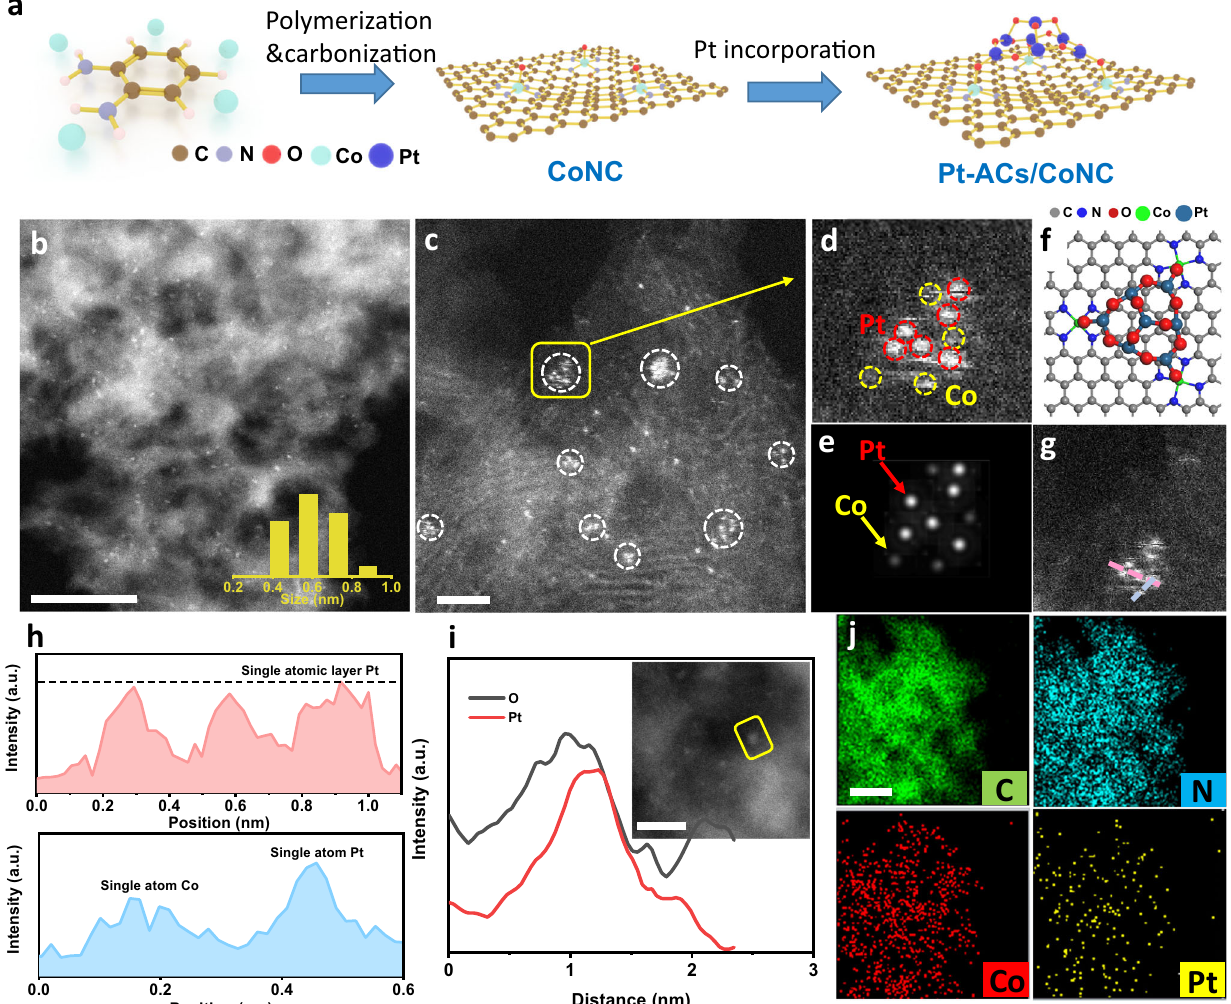
Fig. 1 Structural characterization of Pt-ACs/CoNC. a Schematic illustration of the preparation of Pt-ACs/CoNC. b , c STEM images of Pt-ACs/CoNC. Scale bar, 20 and 2 nm, respectively. d – f Magni fi ed HAADF-STEM image of Pt-ACs/CoNC, its corresponding simulated image and DFT optimized structure. g – h The extracted line pro fi les along with the red and blue directions. i EDS analysis of Pt-ACs/CoNC, and the inset is the HAADF-STEM image at a low voltage of 60 kV. Scale bar, 5 nm. j STEM-EDS elemental mapping of Pt-ACs/CoNC. Scale bar, 10